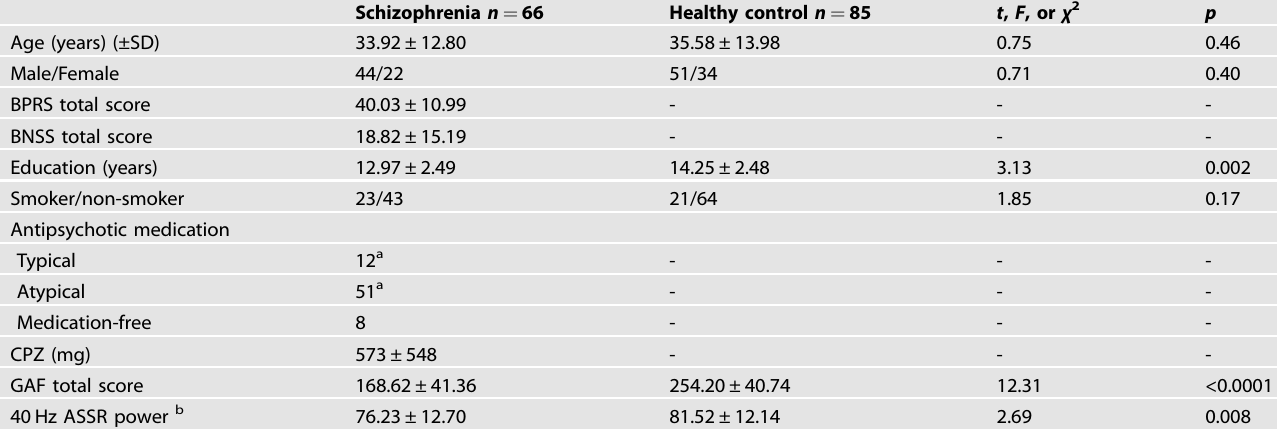
Table 1. Demographic and clinical